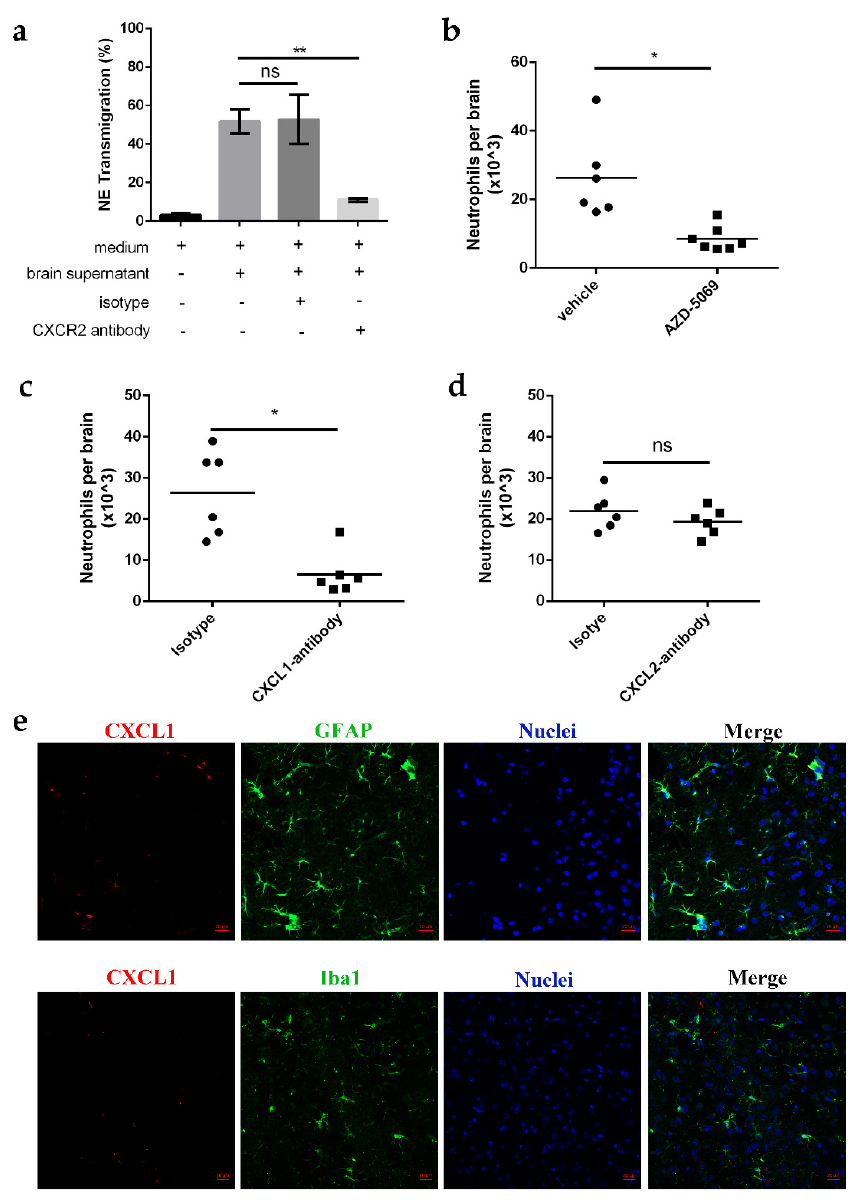
Figure 5. Astrocyte-derived chemokine CXCL1 is required for neutrophil recruitment to CNS during E. coli K1 infection. ( a ) Primary neutrophils isolated from bone marrow of 6-week-old mice were treated with either CXCR2 antibody or isotype control before inducing neutrophil transmigration. Transmigrated cells were counted 3 h after infection with E. coli K1. Data are presented as mean ± SD, n = 3 independent experiments. ( b ) Neutrophil counts in the brains of mice that were pretreated with AZD-5069 (a CXCR2 inhibitor) or vehicle (negative control) and then infected with E. coli K1 for 24 h ( n = 6 mice for vehicle; n = 6 mice for AZD-5069). ( c , d ) Neutrophil counts in the brains of mice that were co-injected with E. coli K1 and CXCL1 ( c ) and CXCL2 ( d ) antibody for 12 h ( n = 6 mice per group). ( e ) Confocal laser microscopy analysis showed that CXCL1 co-localized with astrocytes (GFAP + ) but not microglia (Iba1 + ). Scale bars, 20 μ m. Images are representative of three independent experiments. p values were determined using Student’s t -test ( a ) or Mann–Whitney U test ( b – d ). * p < 0.05; ** p < 0.01; ns, not significant.